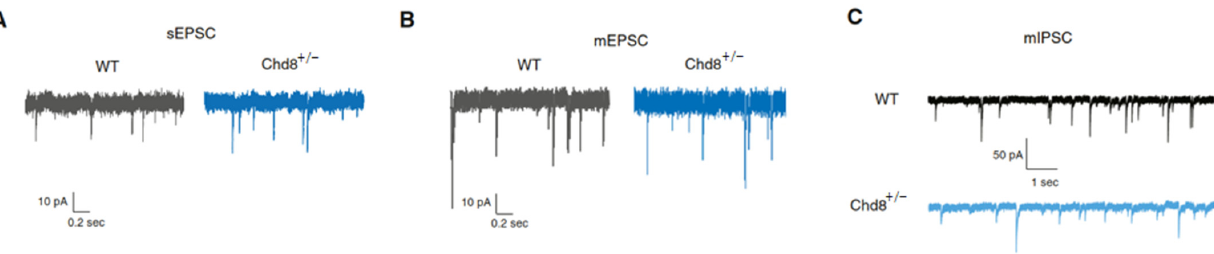
Figure 2. Schematic representation of synaptic dysfunction within MSNs in the NAc of Chd8 heterozygote mice. ( A ) Representative sEPSC (spontaneous excitatory postsynaptic current) traces show an increase in sEPSC frequency and amplitude in Chd8 +/ − mice relative to wild ‐ type ( WT ) littermates. ( B ) Representative mEPSC (miniature excitatory postsynaptic current) traces show no difference in either mEPSC frequency or amplitude between Chd8 +/ − and WT mice. ( C ) Representative mIPSC (miniature inhibitory current) traces show no difference between mIPSC frequency between genotypes albeit a decrease in mIPSC amplitude in Chd8 +/ − mice relative to WT littermates. Schematic adapted from [37], attribution license 4985961341269.